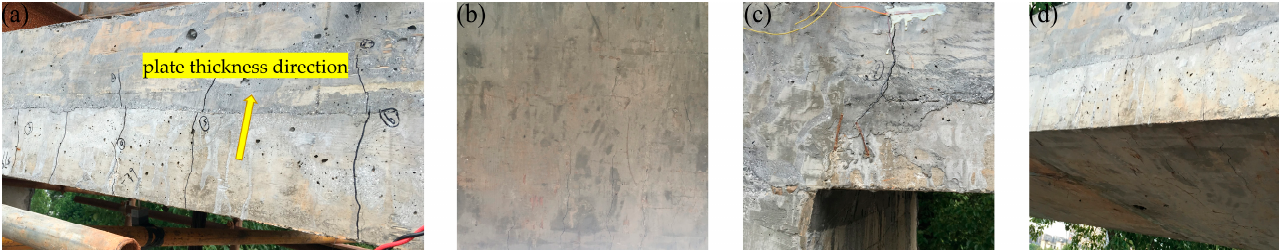
Figure 8. Development of cracks at the end of the test: ( a ) cracks in top plate developing along thick- ness direction when the load was increased to 722 kN; ( b ) long cracks when the load reached 794 kN; ( c ) a main crack in midspan tensile zone when loaded to 848 kN; and ( d ) cracks in top plate after test was stopped.